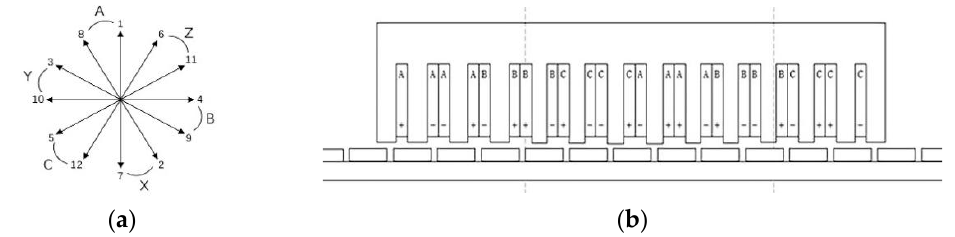
Figure 1. PMLSM structure.